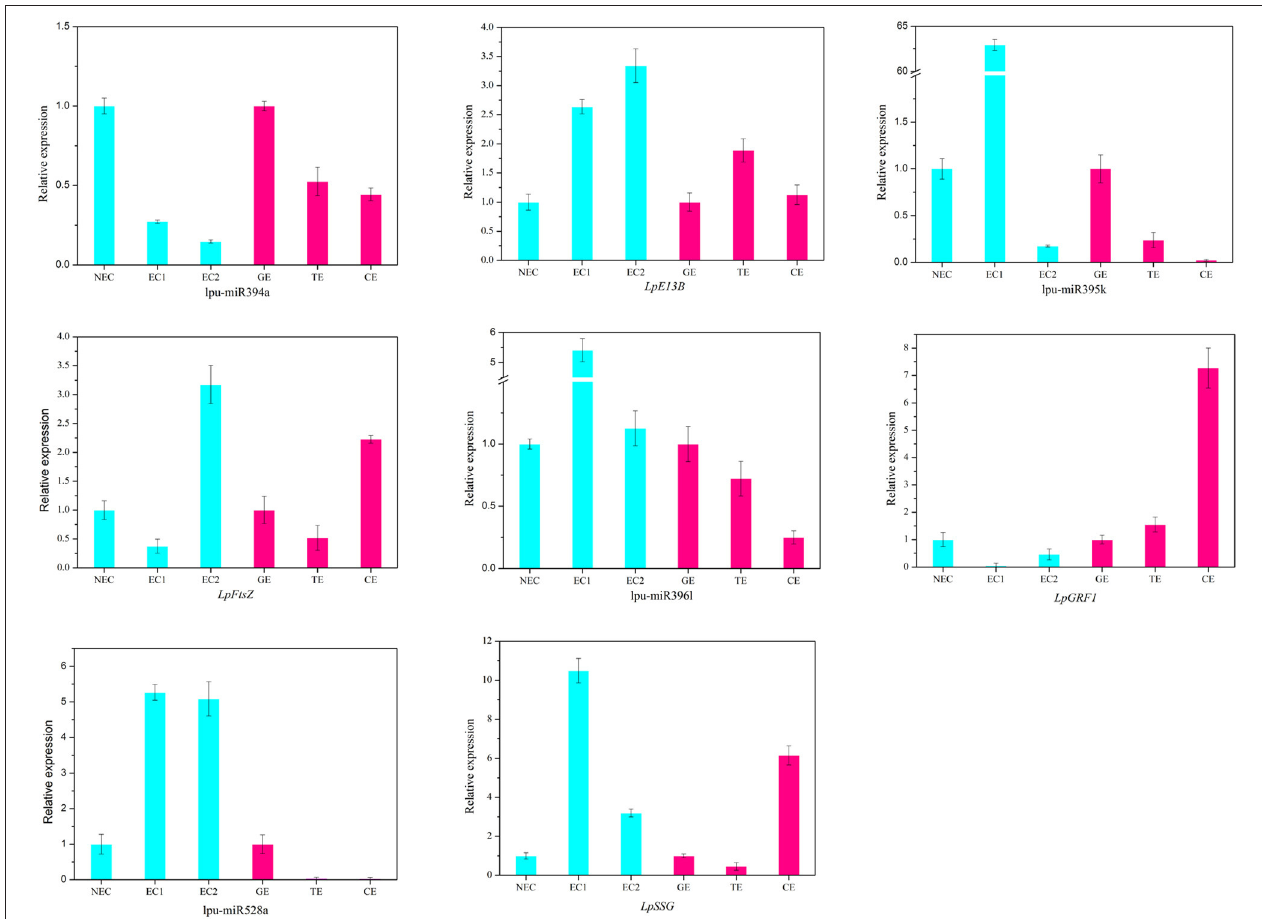
FIGURE 7 | Expression profiles of 4 miRNAs and 4 targets during Lilium SE. LpE13B (c44501_g1_i1) targeted by lpu-miR394a; LpFtsZ (c46557_g1_i1) targeted by lpu-miR395k; LpGRF1 (c36759_g1_i2) targeted by lpu-miR396l; LpSSG (c44221_g1_i1) targeted by lpu-miR528a. NEC, non-embryogenic callus; EC1, embryogenic callus induced in 4 weeks; EC2, embryogenic callus induced in 6 weeks; GE, globular embryo; TE, torpedo embryo; CE, cotyledon embryo. The qRT-PCR values are the means ± SE of three replicates.